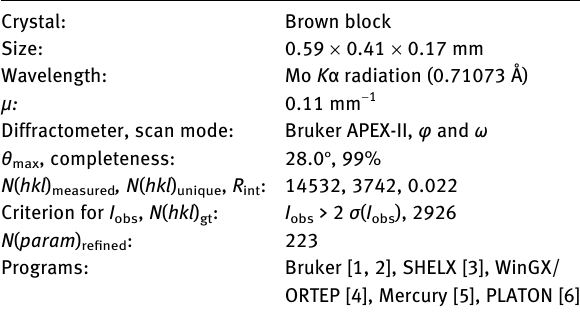
Table  : Data collection and